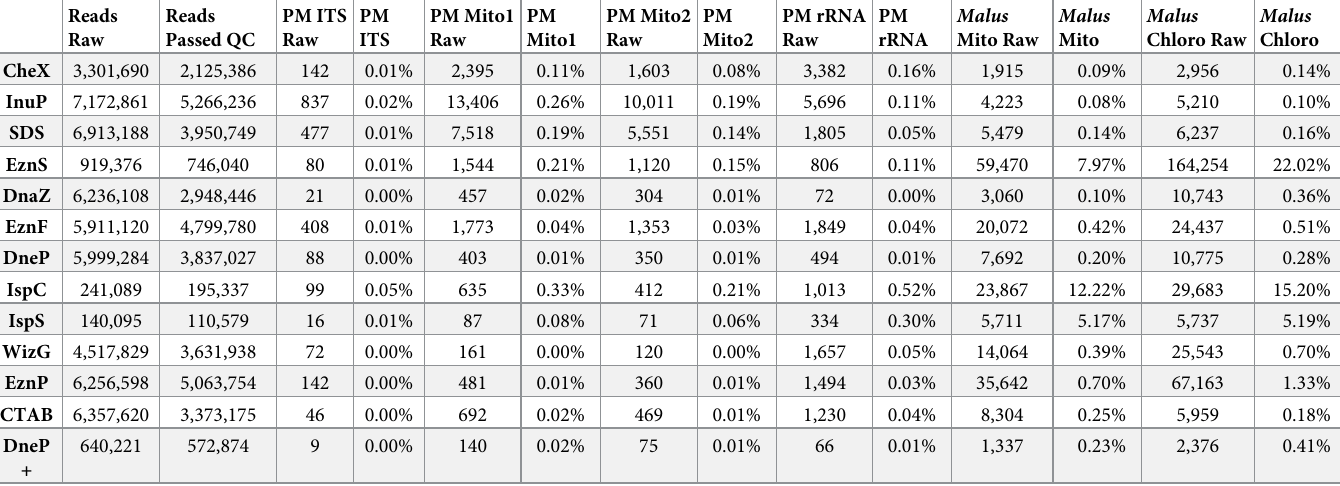
Table 5. Illumina Nextera XT 1 VPRI P . leucotricha sequencing alignment results taken from vision alignment.